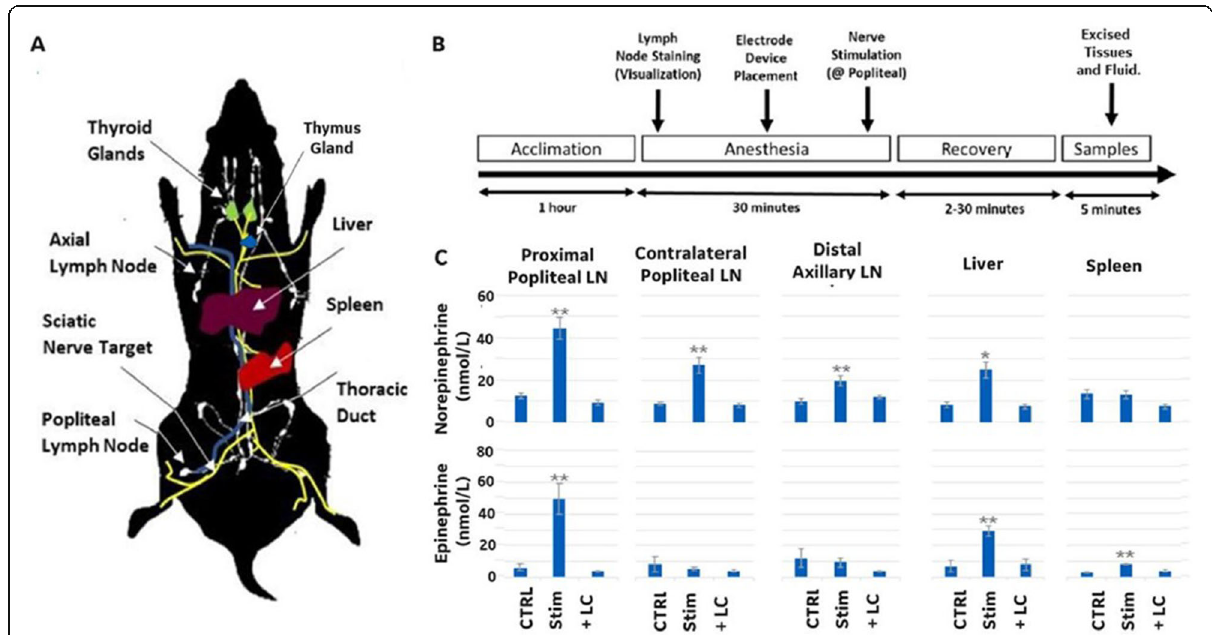
Fig. 1 a A schematic diagram of the primary and secondary lymph organs in the rat, along with potential paths of the lymphatic ducts and associated connecting nerves (green- thyroid glands, purple- liver, red- spleen, blue- lymphatic duct, white- lymph nodes and lymphatic ducts, yellow- lymph associated nerves). b A timeline of the experimental procedure for lymph node nerve stimulation and subsequent tissue excision and analysis. c Normalized concentration of norepinephrine and epinephrine in excised tissues with (Stim) and without (sham control; CTRL) electrical sciatic nerve stimulation (see materials and methods for stimulation details), or with electrical stimulation following local lidocaine administration (+LC). N = 7. One way ANOVA with multiple comparison analysis * = p ≤ 0.05, ** = p ≤ 0.005,*** = p ≤ 0.0005; Electrical